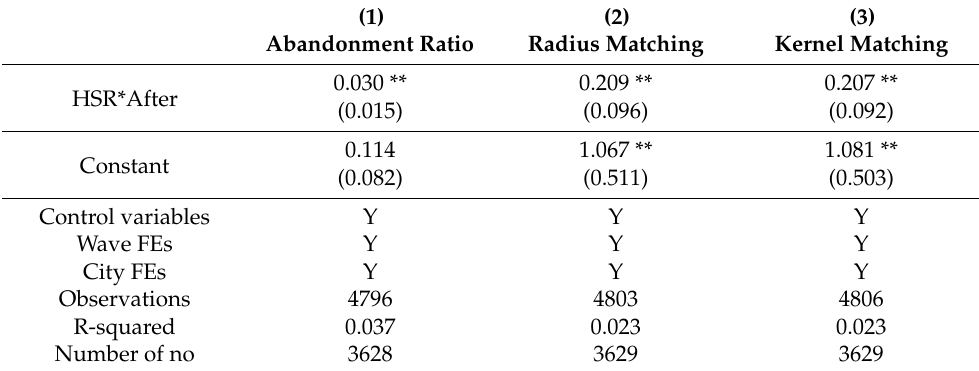
Table 5. Robustness checks for different indicators and the matching